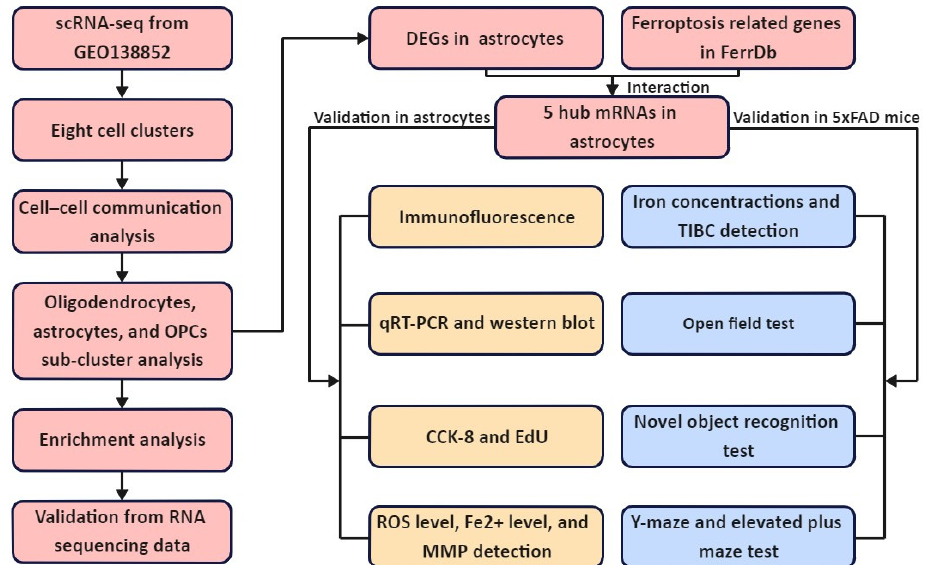
Figure 1. Study flowchart. scRNA-seq: single-cell RNA sequencing. OPCs: oligodendrocyte progeni- tor cells. DEGs: differentially expressed genes. qRT-PCR: quantitative real-time reverse transcrip- tion-polymerase chain reaction. CCK-8: cell counting kit-8. EdU: 5-ethynyl-20-deoxyuridine. MMP: mitochondrial membrane potential. TIBC: total iron binding capacity.